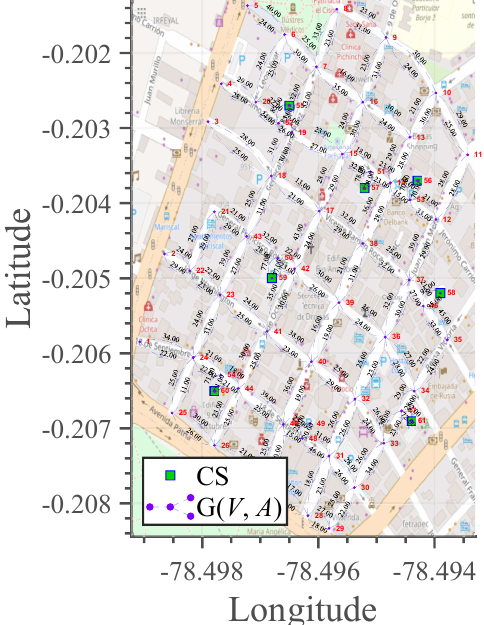
Figure 4. A study case at the level of trajectories in an area of 523.4 m 2 in Quito,